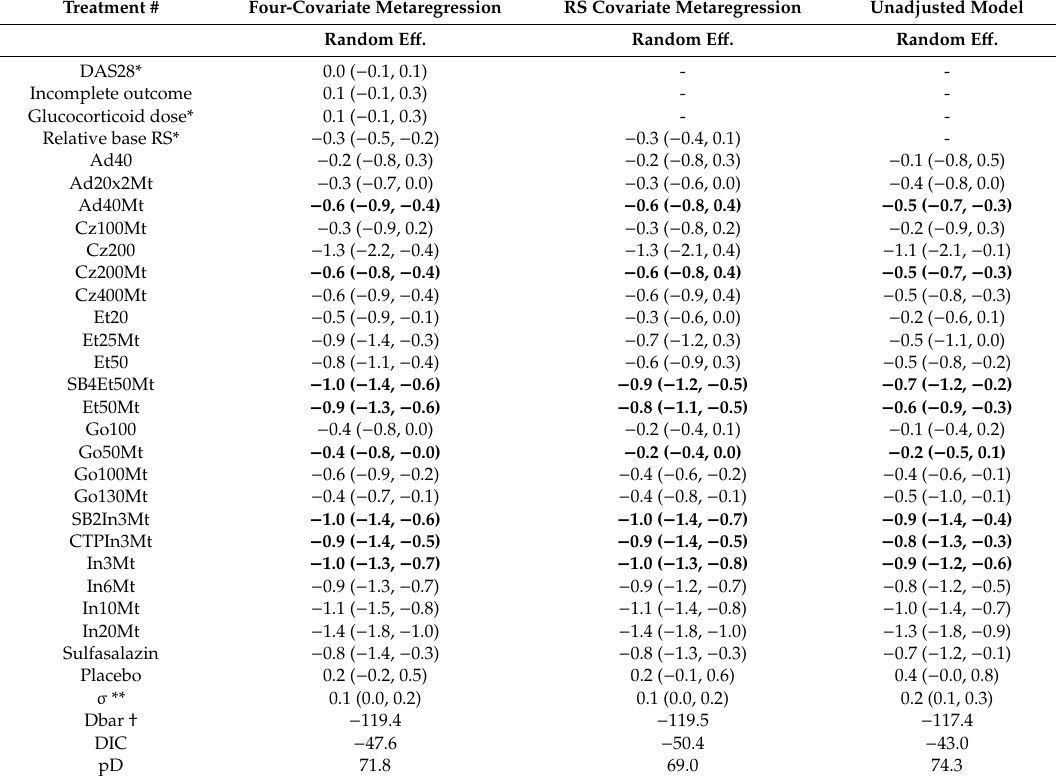
Table 3. Di ff erence in annual percent point progression between each of the investigated treatments, compared to methotrexate. Positive values favour methotrexate. Values are median of posterior distribution (95%